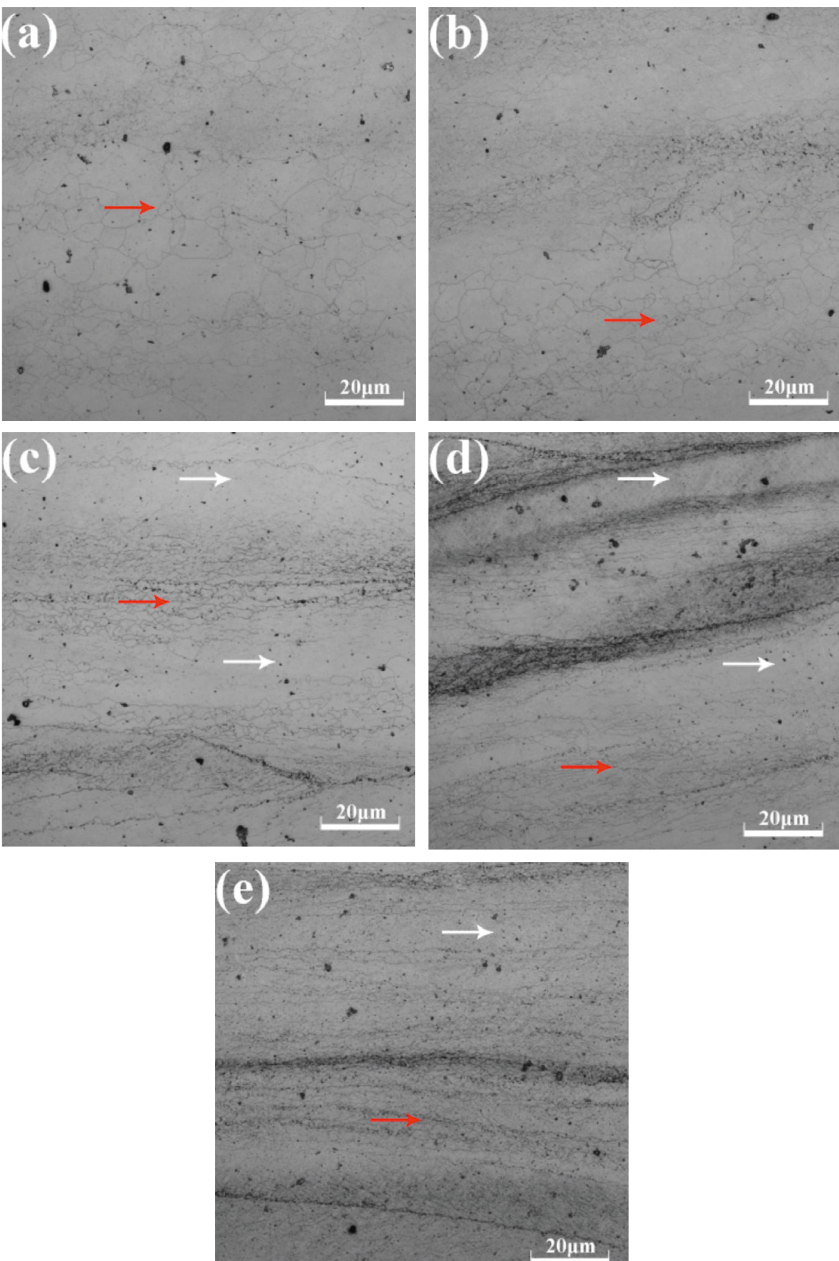
Figure 10: Optical microstructure of 5CrNiMoV steel deformed at the temperature of 830 ° C: (a) _ ε � 0.001s − 1 , (b) _ ε � 0.01s − 1 , (c) _ ε � 0.1s − 1 , (d) _ ε � 1s − 1 , and (e) _ ε � 10 s − 1